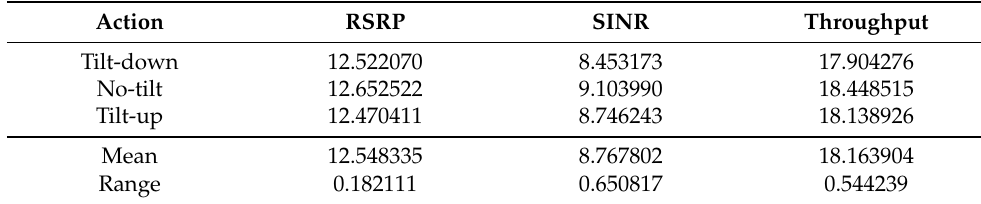
Table 1. Base value for each action and reward component at the RL level.